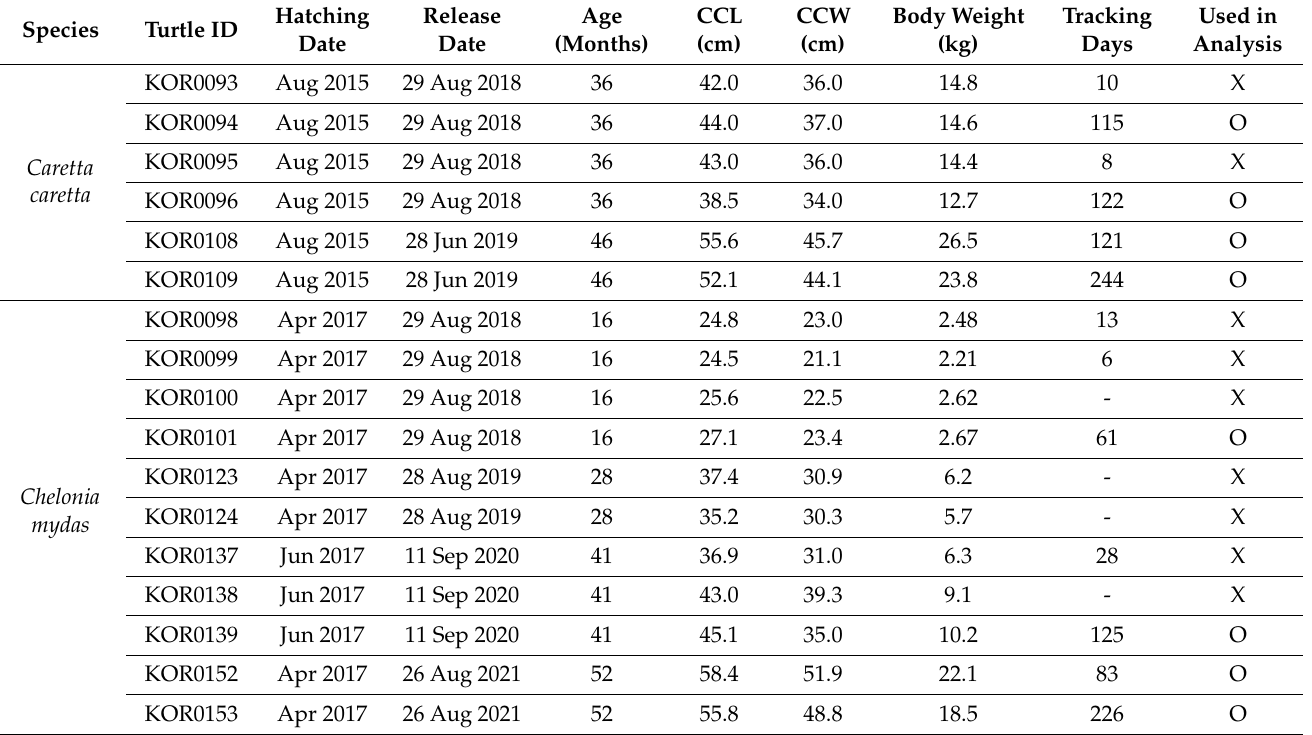
Table 1. Individual information and characteristics of Caretta caretta and Chelonia mydas satellite tracked and analyzed in the present study. The turtles whose transmitter signal had been cut off immediately after release are marked with ‘-’ in ‘Tracking Days’. CCL = curved carapace length; CCW = curved carapace